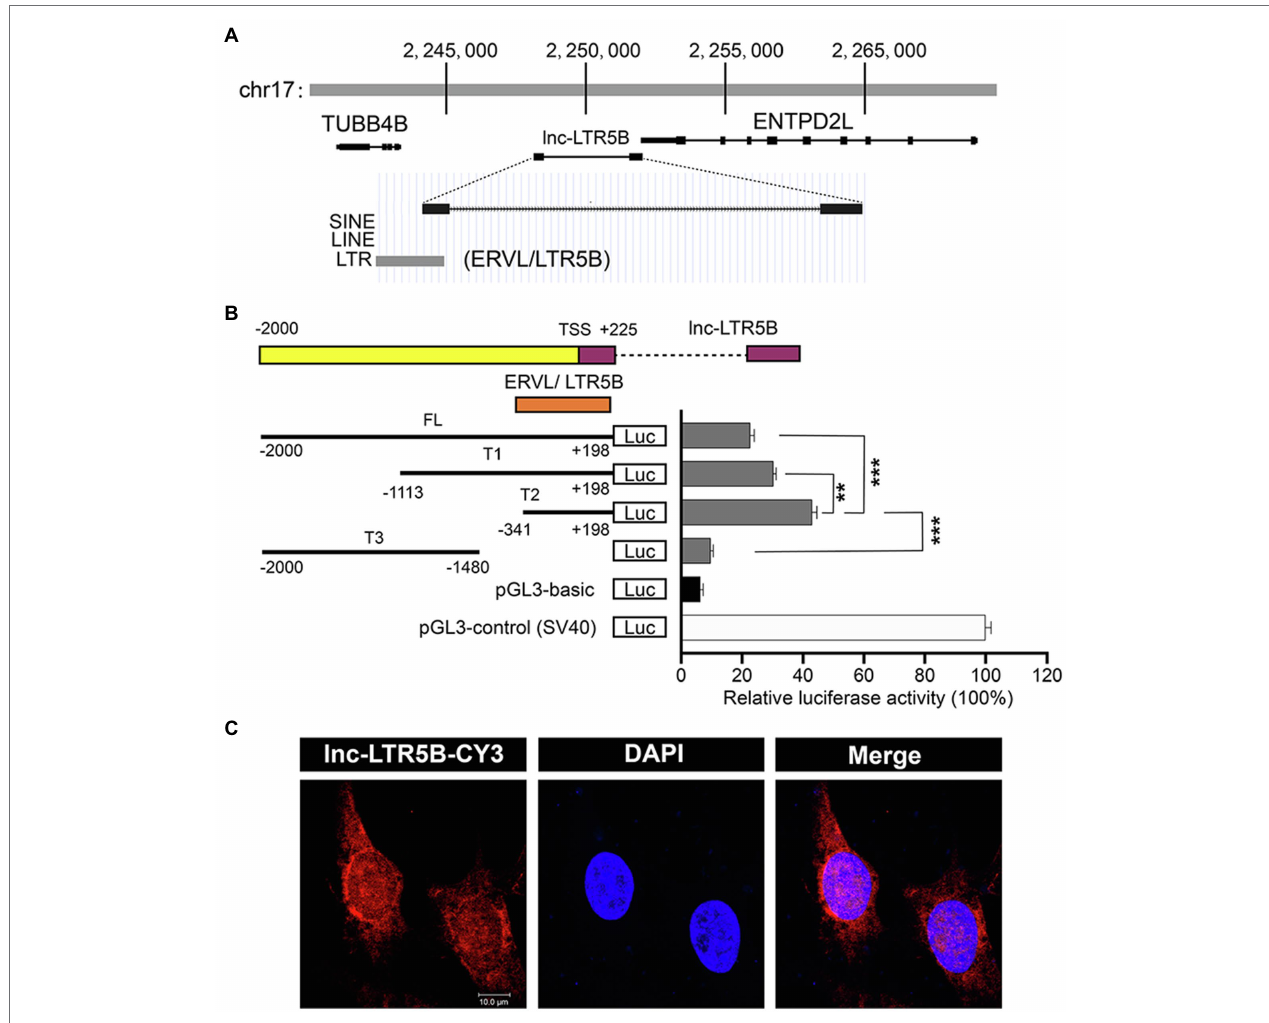
FIGURE 2 | Characterization of the lnc-LTR5B. (A) Schematic map of lnc-LTR5B. lnc-LTR5B is located on chromosome 17 and is flanked by the coding genes TUBB4B and ENTPD2L. (B) Dual-luciferase assays of lnc-LTR5B promoter activity in HEK293T cells transfected with the indicated plasmids. Schematic illustration of truncation constructs of lnc-LTR5B promoter region ( − 2000 to +198 relative to TSS). Data are presented as the mean ± SD, n = 3; ** p < 0.01, *** p < 0.001 (two- tailed unpaired Student’s t test). (C) Confocal RNA FISH images showing the distribution of lnc-LTR5B in DF-1 cells. The lnc-LTR5B probes labeled with CY3 (red), and nuclei are stained with 4 ' , 6-diamidino-2-phenylindole (DAPI; blue), Scale bars, 10 μ